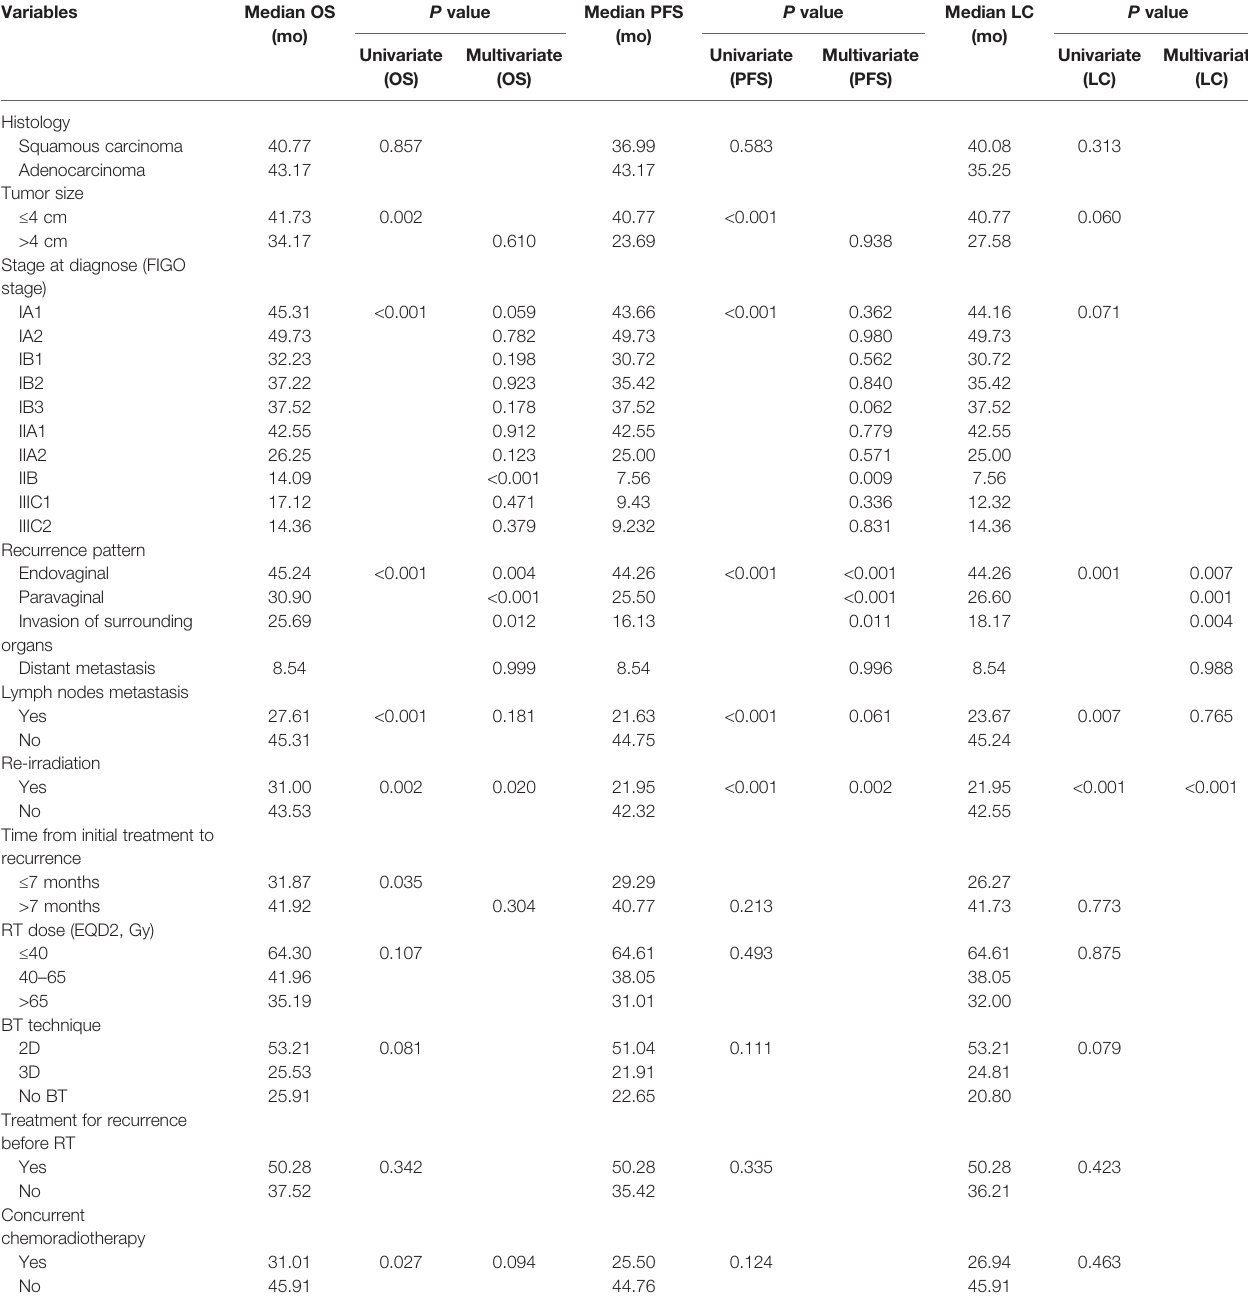
FIGO, International Federation of Gynecology and Obstetrics; BT,